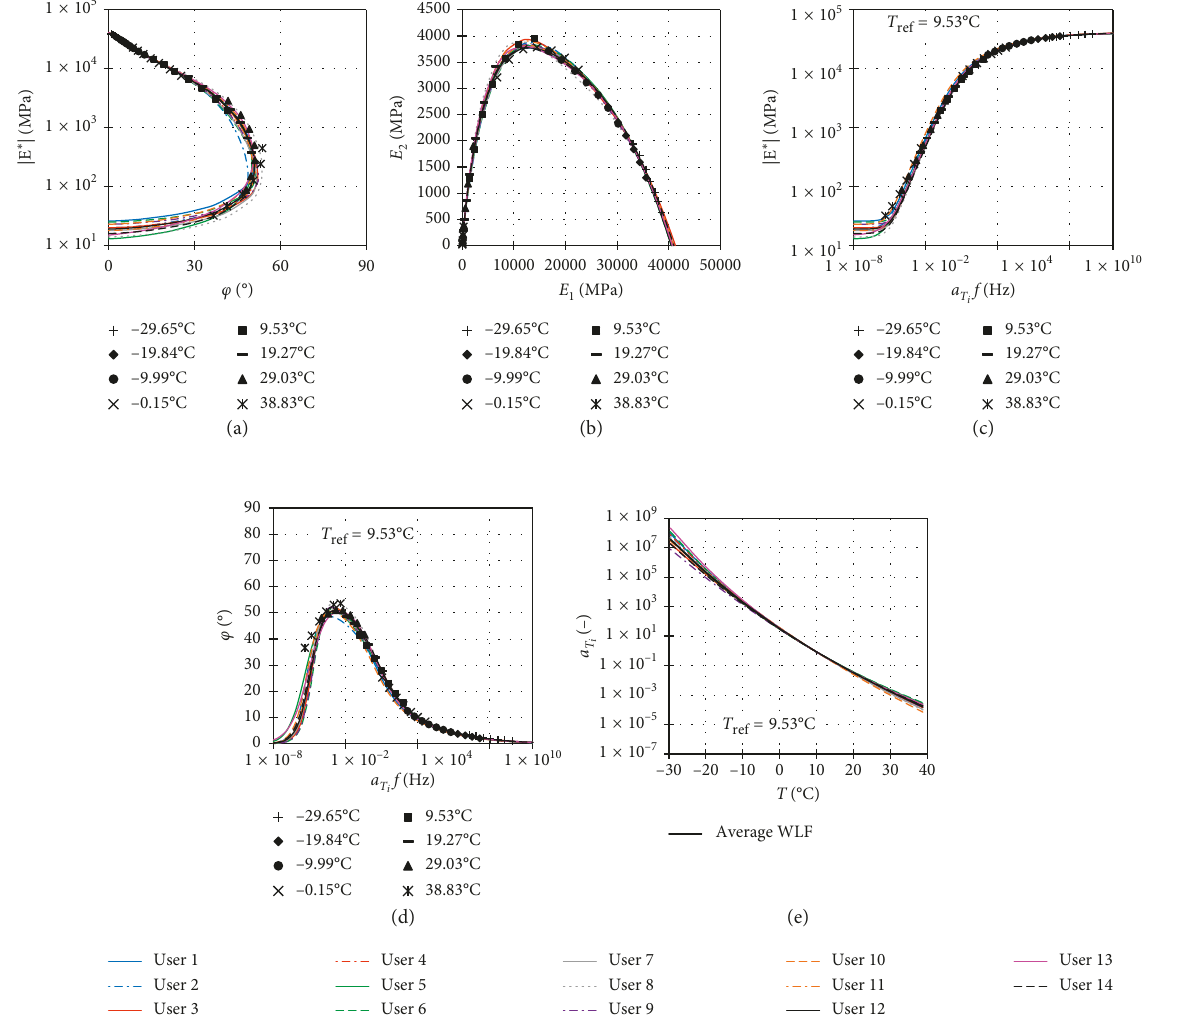
Figure 9: Results of 2S2P1D calibration panel for a mixture: (a) Cole-Cole plan; (b) Black space; (c) master curves of master curves of φ at 9.53 ° C; (e) WLF equation used by users to obtain master curves in (c and d) and average WLF